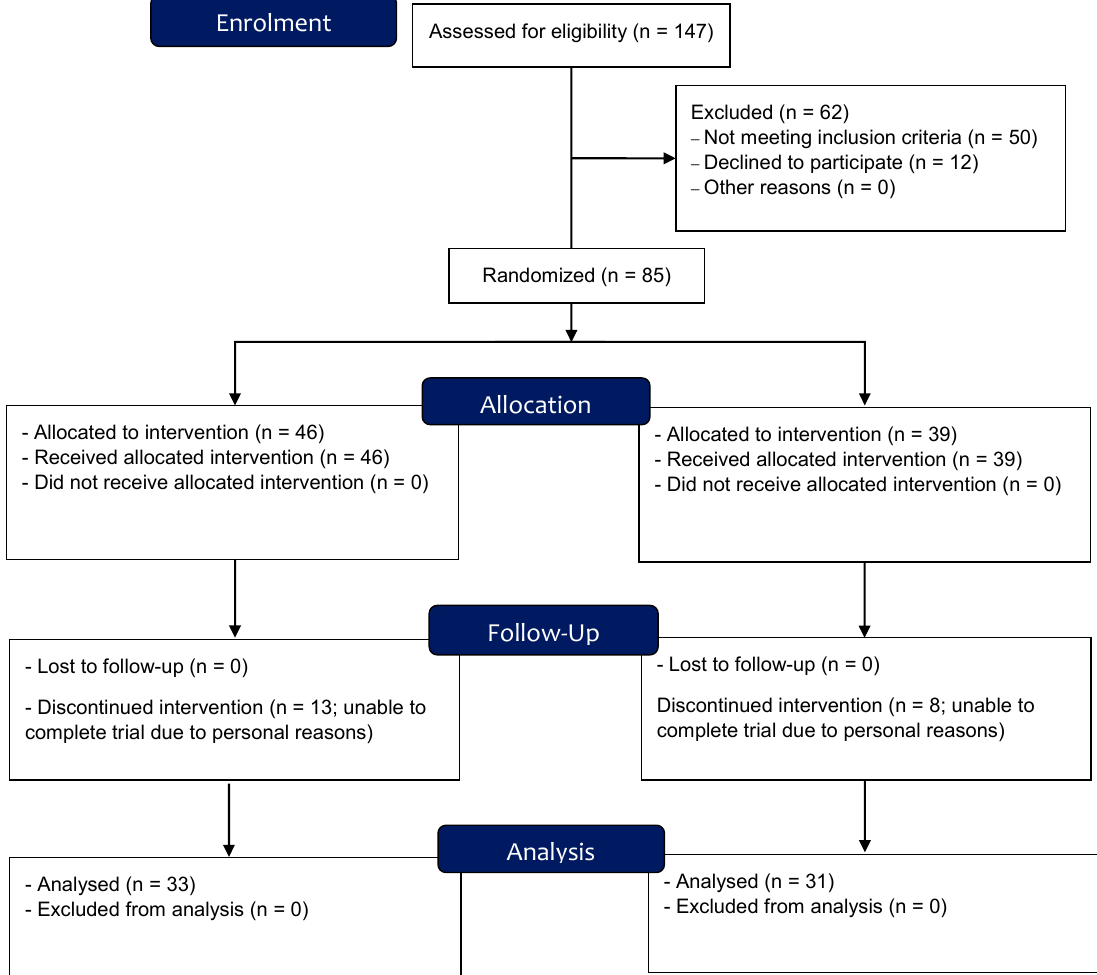
Figure 1. Consort flow diagram of the ‘Healthy Eating and Living Study’ (HEALS) trial.